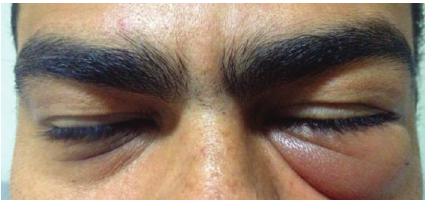
Figure 1: Hard and cold edema of the lower left eyelid with discreet ipsilateral proptosis.